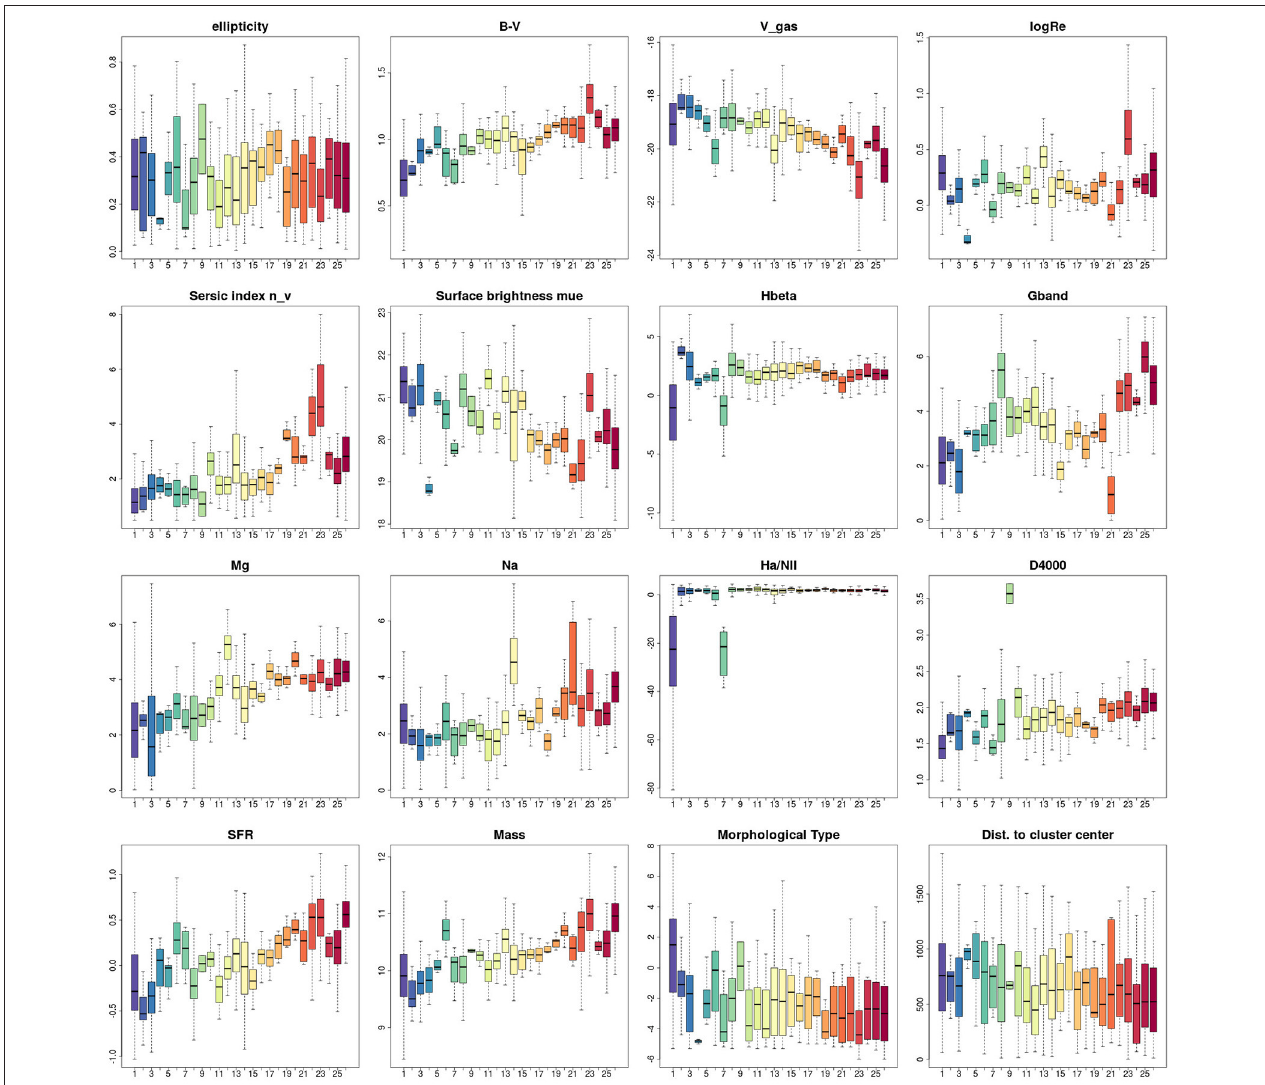
FIGURE 4 | Boxplots for the groups in the WINGS sample as defined on the tree in Figure 3